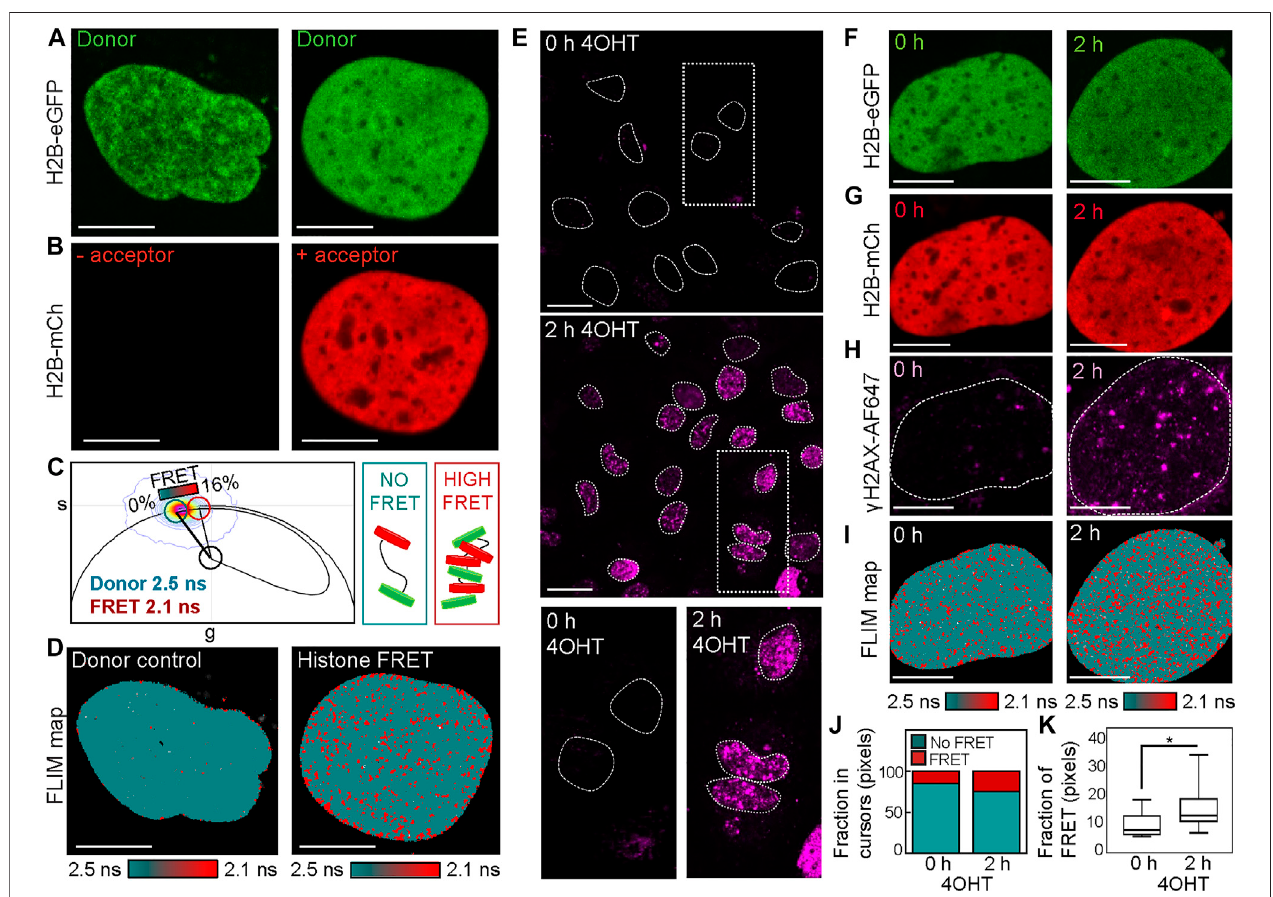
FIGURE 1 | Phasor histone FLIM-FRET coupled with γ H2AX IF revealsDSB induction in the DIvA cell system toinduce nuclear-wide chromatin compaction. (A,B) FixedDIvAnucleiexpressingH2B-eGFP (A) intheabsence (left) versuspresence (right) ofH2B-mCh (B) (scalebar 10 μ m). (C) Phasor distribution ofH2B-eGFP inthe absence (donor control) versus presence of H2B-mCh (histone FRET experiment) with a theoretical FRET trajectory superimposed (black curve) that extends from the unquenched donor lifetime (teal cursor, 2.5 ns). This FRET trajectory enables characterization of the histone FRET ef fi ciency as 16% (red cursor, 2.1 ns) and de fi nition of a palette to detect open (teal) versus compact (red) chromatin. (D) FLIM maps of H2B-eGFP in the absence (left) versus presence (right) of H2B-mCh pseudo-colored according tothe FRETpalette de fi ned inthe phasorplotofpanel (C) . (E) IF against γ H2AX inDIvA beforeversusafter 2 hoftreatmentwith4OHT (scale bar 20 μ m). (F – H) Fixed DIvA nuclei co-expressing the histone FRET pair H2B-eGFP (F) and H2B-mCh (G) with IF against γ H2AX (H) in the absence (left) versus presence (right) of 2 h of treatment with 4OHT (scale bar 10 μ m). (I) FLIM maps of the cells presented in panels (F – H) pseudo-colored according to the FRET palette de fi nedinpanel (C) . (J) Quanti fi cationofthefractionofpixelsinthephasorcursorthatreportsnoFRET(openchromatin)versushistoneFRET(compactchromatin)inthe cells presented in panel (I) . (K) Quanti fi cation of the fraction of pixels in the phasor cursor that reports histone FRET (compact chromatin) across multiple cells before versus after 2 h of 4OHT treatment (N (cid:1) 11 and 47 cells, respectively, three biological replicates). The box and whisker plot shows the minimum, maximum, and sample median. * p < 0.05 (unpaired t